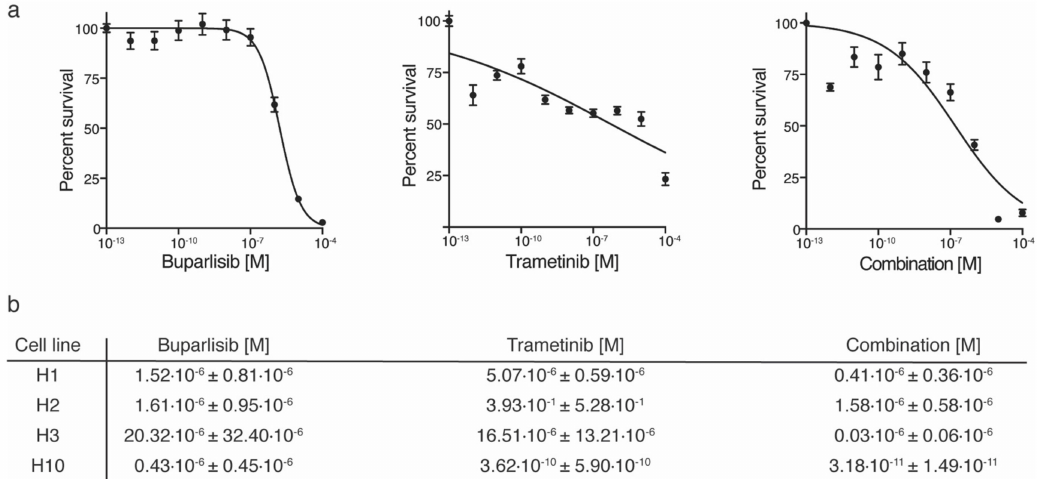
Figure 1. Cell survival curves of cells grown as monolayers after treatment with buparlisib, trametinib or a combination with increasing drug concentrations (0.000001 µ M–100 µ M). ( a ) representative graphs of H1 cells treated with increasing drug concentrations for 72 h, with either buparlisib, trametinib, or combined treatment; ( b ) table showing the IC 50 doses, the doses at which 50% of the cells were growth inhibited, for all four cell lines studied. The experiments were performed in triplicate ( n = 6 per experiment per drug concentration).